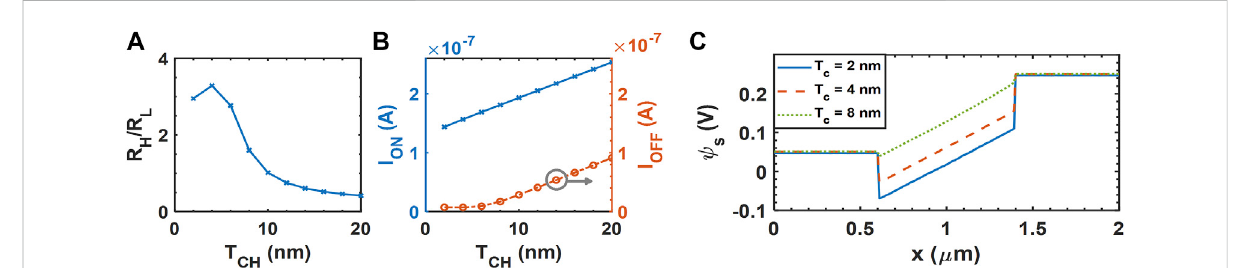
FIGURE 6 (A) R H / R L resistance ratio as a function of the channel thickness T CH , estimated from the hysteretic FeFET characteristics at V DS = 0.2 V. (B) Corresponding I ON and I OFF as a function of T CH , extracted from the DC transfer characteristics at 4 V and − 4 V, respectively. (C) Surface potential ψ S alongtheWO x channelat V G = − 4 Vand V DS =0.2 V.Thebeginningofthesourcecontactissituatedat x =0,thegatestartsat x =0.6 μ mandgoestill x = 1.4 μ m.